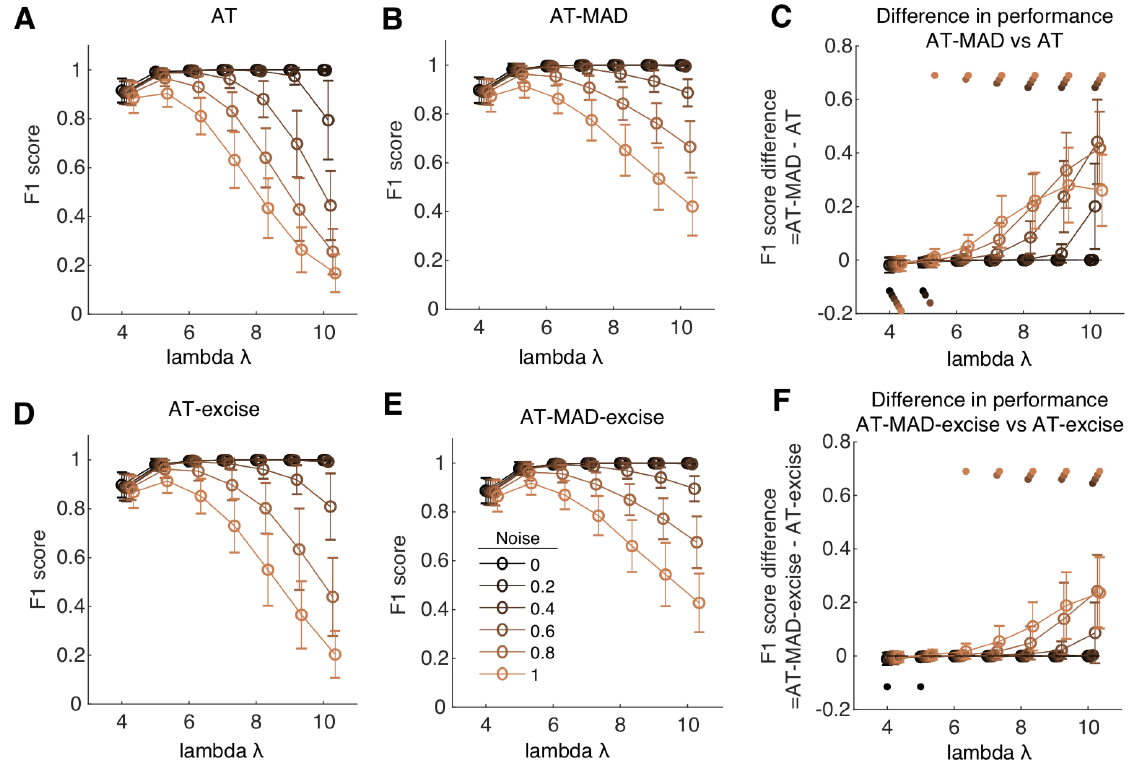
Figure 4. MAD is more robust to changes in threshold confidence level (A) Mean and standard deviation of the detection performance of the AT algorithm as a function of lambda for various levels of noise. Copper-tone color indicates the level of noise, with darker (lighter) colors indicating less (more) noise. At low noise levels (<0.2), performance does not depend on the choice of lambda. At moderate noise levels (0.4), performance rapidly decreases at very high lambda values (=10). However, with high noise levels, there is a substantial and rapid decrease in performance with higher lambda values. (B) Same as (A) but for the AT-MAD algorithm. Performance is high for low-moderate noise levels (<0.6). For higher noise levels, performance decreases at a slower rate for higher lambda values. (C) Difference in detection performance between AT-MAD and AT. Colored dots represent significant differences at the corresponding noise level. Dots above (below) zero depict significant increases (decreases) (p<0.05, multiple comparison corrected). At higher levels of lambda, AT-MAD far outperforms AT. This is especially true for moderate to high-levels of noise. (D-F) Same as (A-C) but for AT-excise (D), AT-MAD-excise (E), and their comparison (F). Results are qualitatively similar as for (A-C). Excising some data points using the original algorithm helps but using MAD still allows for higher lambda